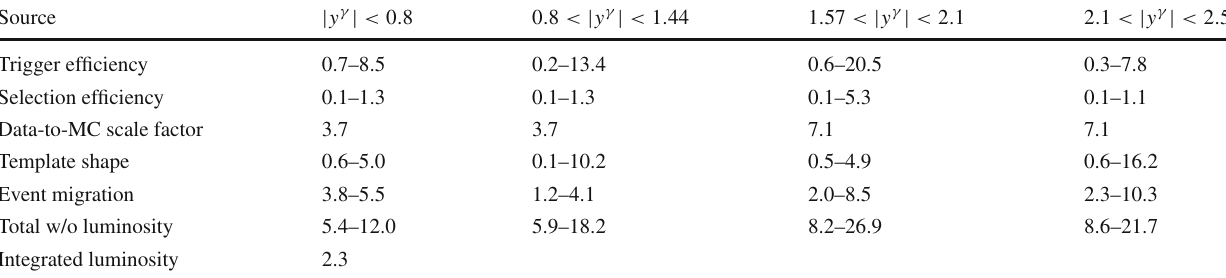
Table 1 Impact on cross sections, in percent, for each systematic uncertainty source in the four photon rapidity regions, | y γ | < 0 . 8, 0 . 8 < | y γ | <